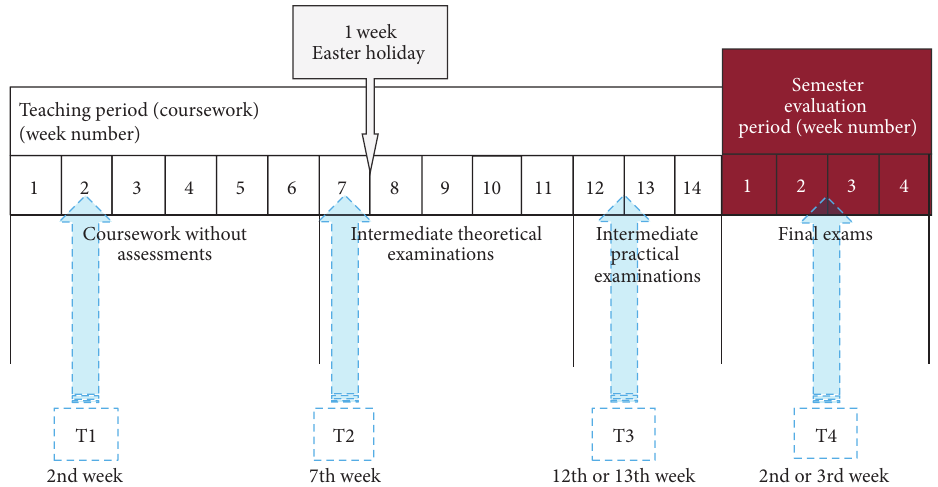
Figure 1: Timing for data collection, in regard to the assessments calendar of 2014-2015 second academic semester.